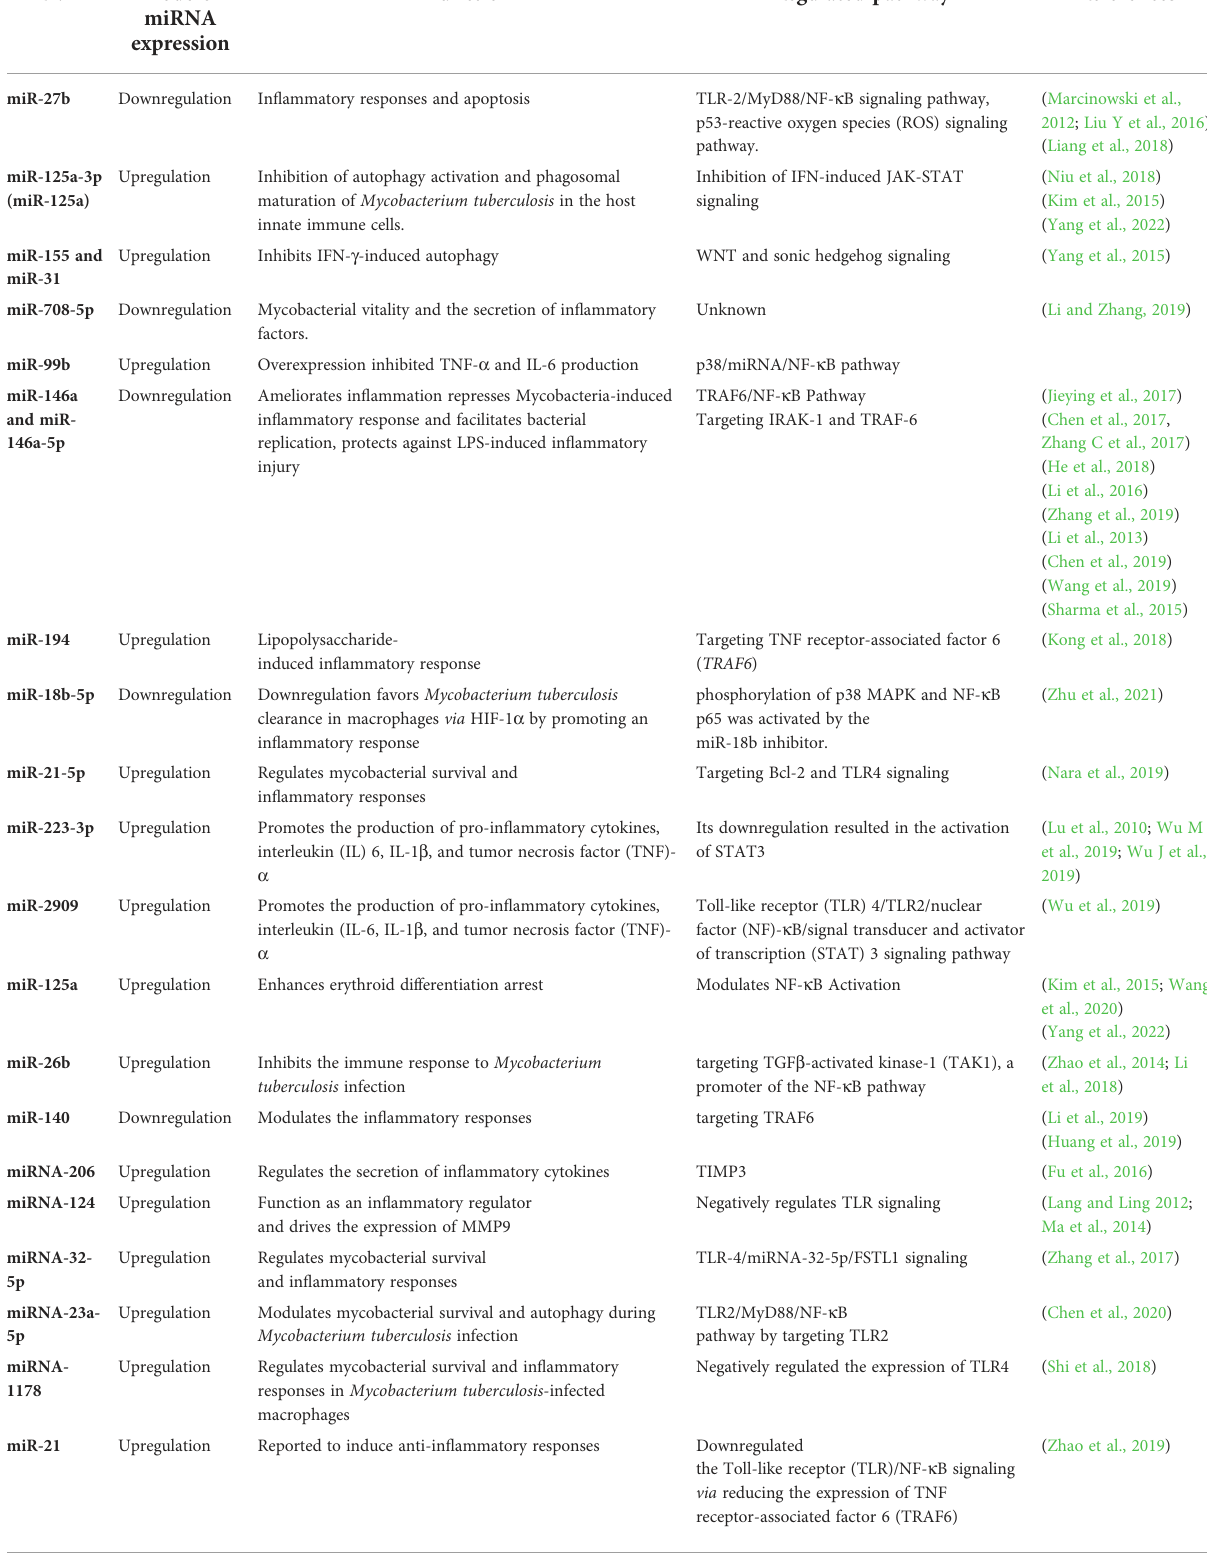
TABLE 1 Role of different miRNAs in the pathogenesis of